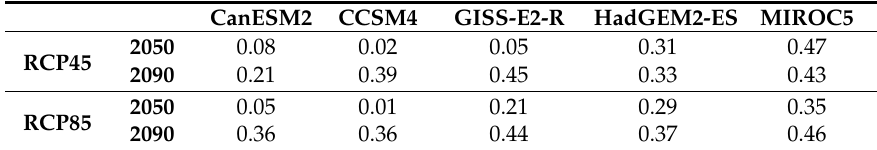
Table 2. Correlation coefficients of changes in CWQI across the Ecoregions between HAWQS and US Basins.